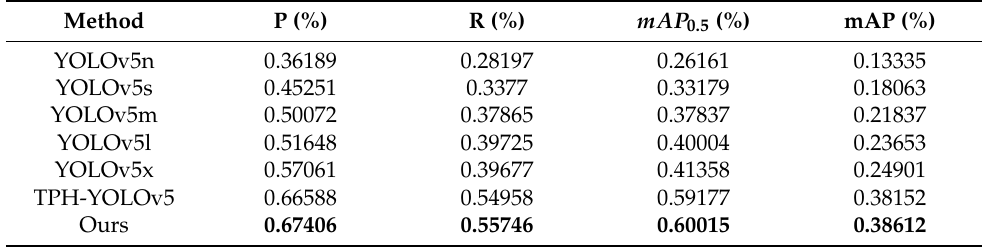
Table 1. Comparison results between the suggested architecture and other